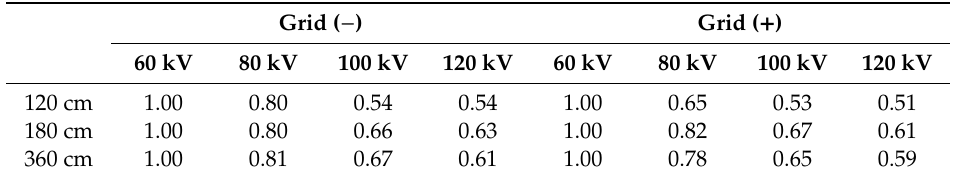
Table 3. The relative values of breast surface doses (BSDs) in the anteroposterior view (normalized at 60 kV).